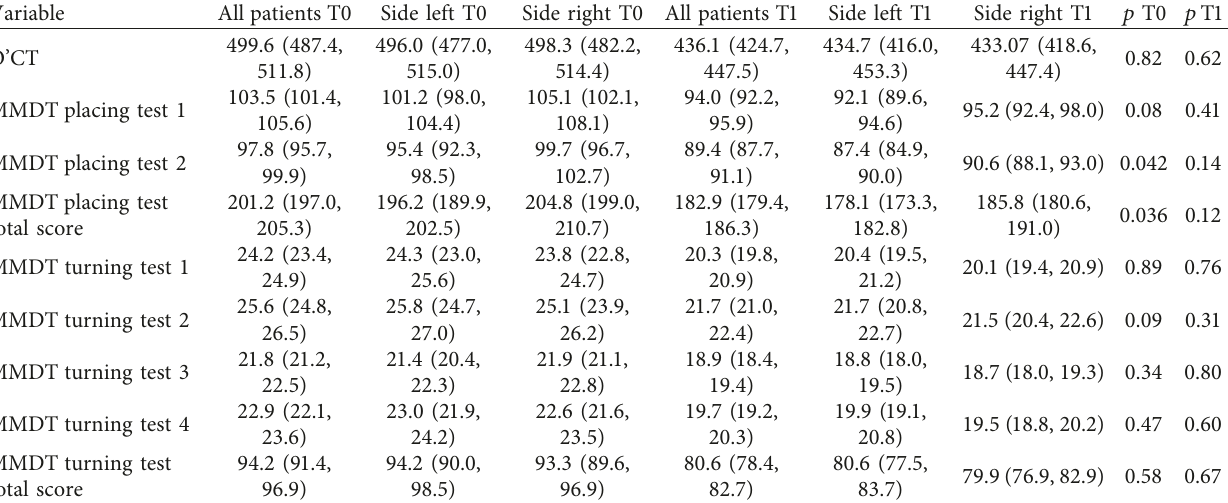
Table 4: Differences (values at discharge—values at admission) in MMDTand O’CTfor patients grouped on the basis of the side of motor symptoms predominance.